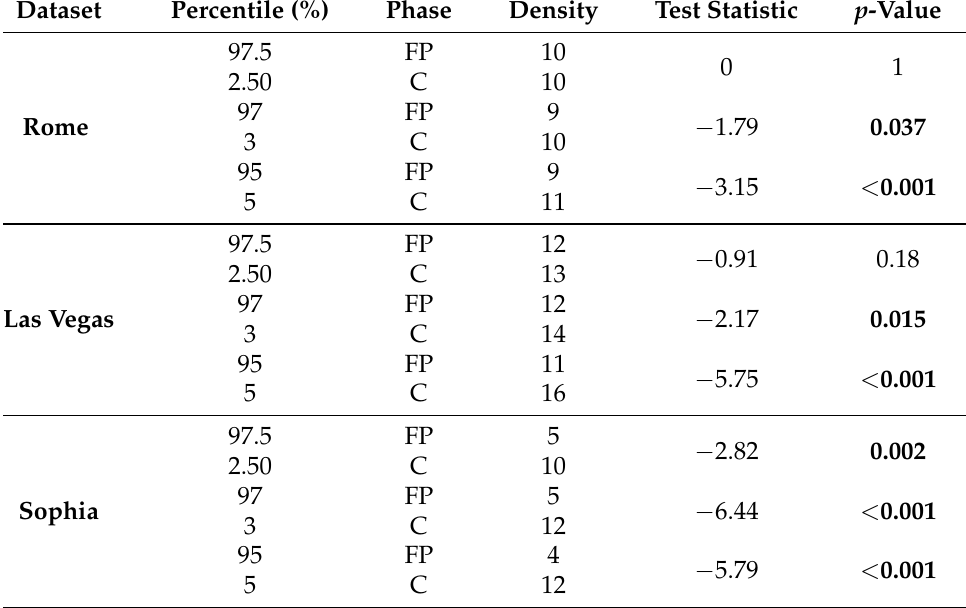
Table A1. Results of model-based cluster analysis using Rome, Las Vegas and Sophia Antipolis data. Phase: estimated phase using cluster analysis. FP, free phase; C, congestion phase. Density, estimated density value at the